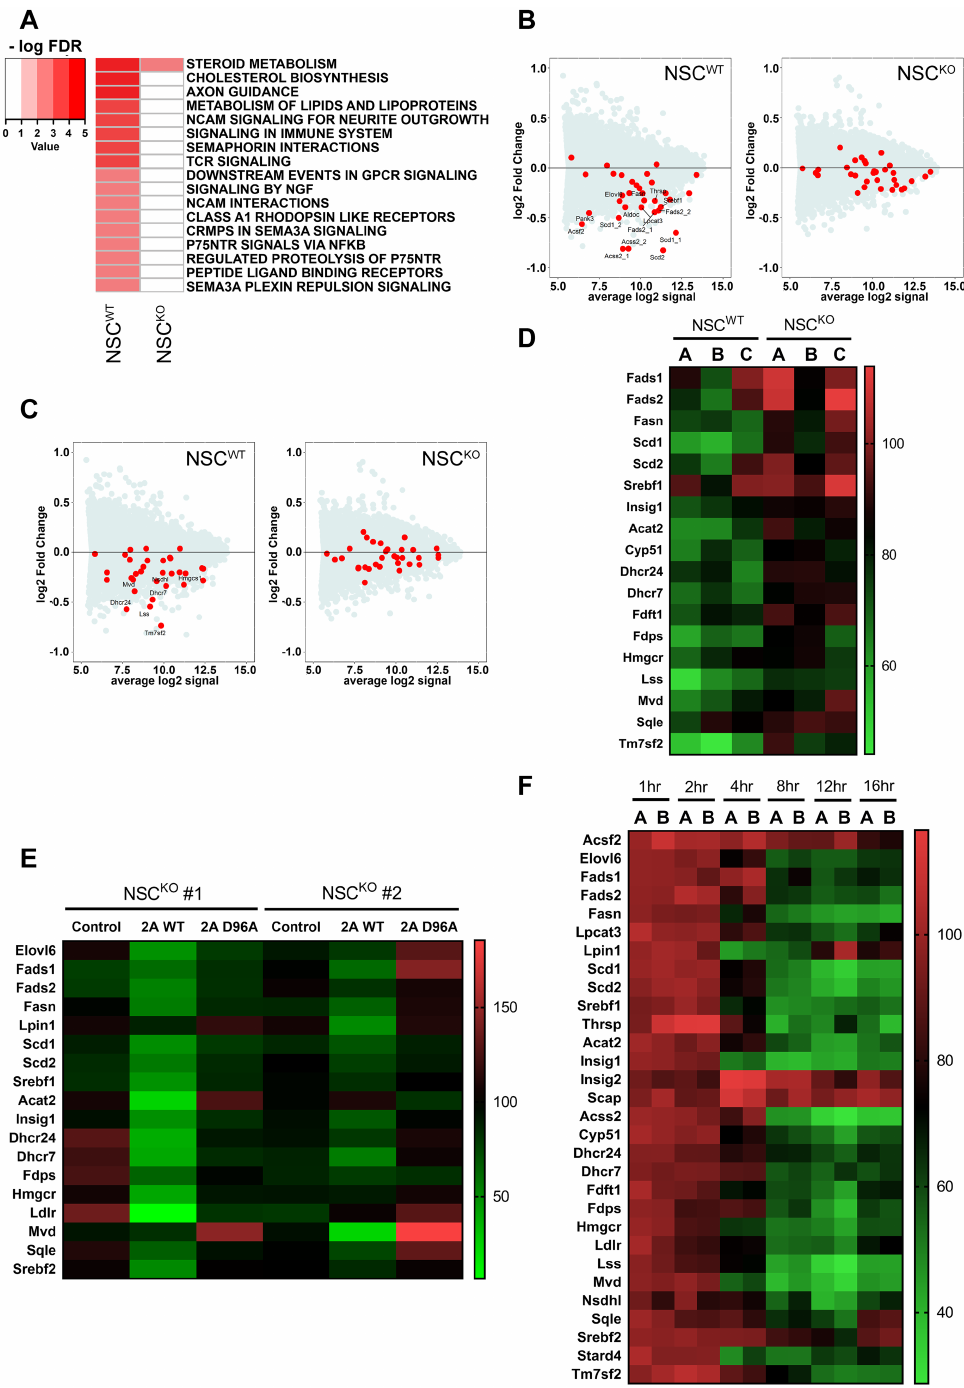
Fig 4. LPC-DHA represses de novo lipogenesis pathways. (A) Gene microarray analysis of NSC WT and NSC KO treated with or without 50 μM LPC-DHA. Heatmap represents commonly down-regulated Reactome pathways in response to LPC-DHA treatment relative to untreated control cells with an FDR (cid:20) 5%. RNA was pooled from 4–5 biological replicates according to their genotype and treatment condition. Color key indicates negative logarithm of the FDR for the selected pathways, for which a higher value indicates the pathway is more significantly different. (B) Srebp-1 target genes were down-regulated by LPC-DHA treatment. MA plot of gene microarray analysis of NSC WT and NSC KO treated with or without 50 μM LPC-DHA. Lipogenic targets of Srebp-1 were down-regulated in LPC-DHA–treated NSC WT but not NSC KO cells. Red dots represent individual Srebp-1 targets with significant changes over the background of